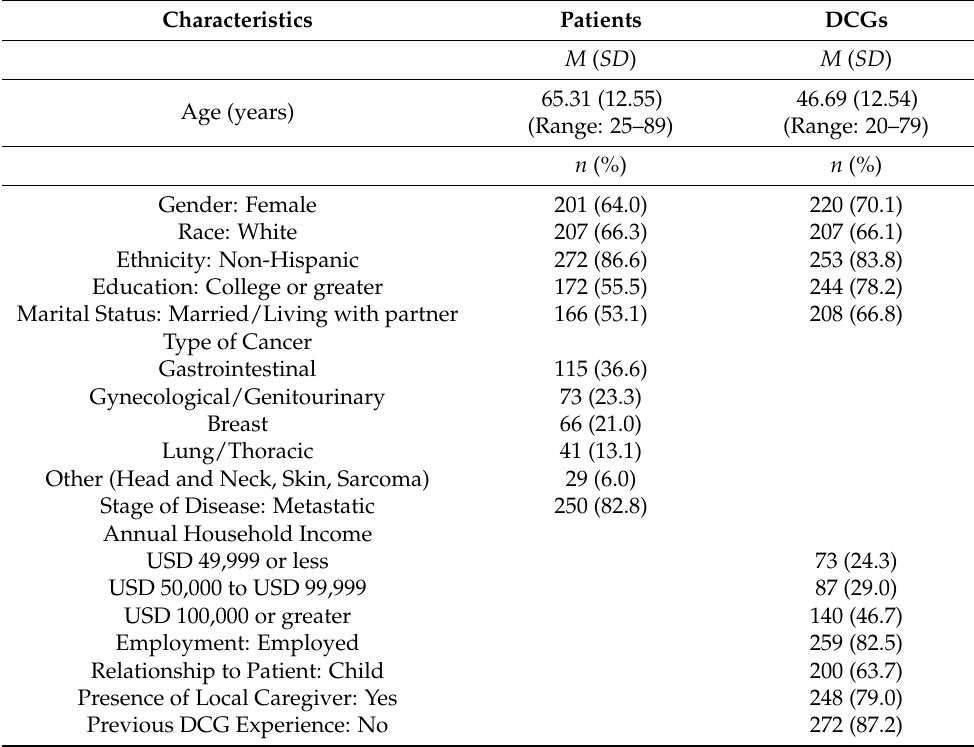
Table 1. Patient and DCGs demographic characteristics and clinical data ( N = 314).